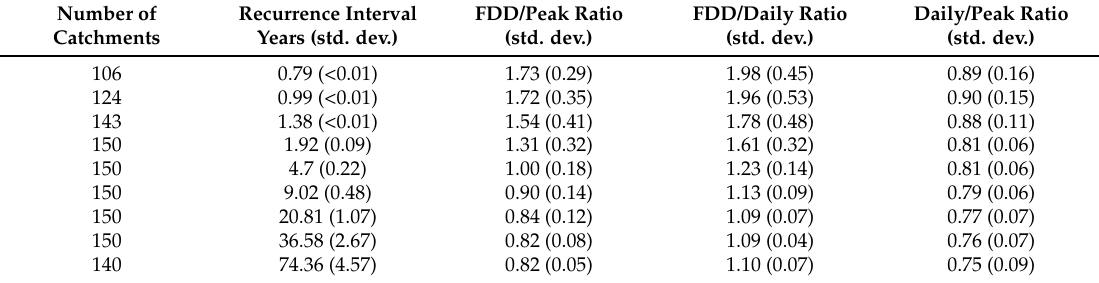
Table 6. Recurrence Interval versus discharge ratios of the full daily distribution (FDD) discharges to those based on an annual series of instantaneous peaks (Peak) and an annual series of peak mean daily discharges (Daily)—based on an analysis of mean results for the six states. Also reported are ratios of the mean daily peaks to the instantaneous peaks. Standard deviations are reported in parentheses. Number of Recurrence Interval FDD/Peak Ratio FDD/Daily Ratio Daily/Peak Ratio Catchments Years (std. dev.) (std. dev.) (std. dev.) (std. dev.)